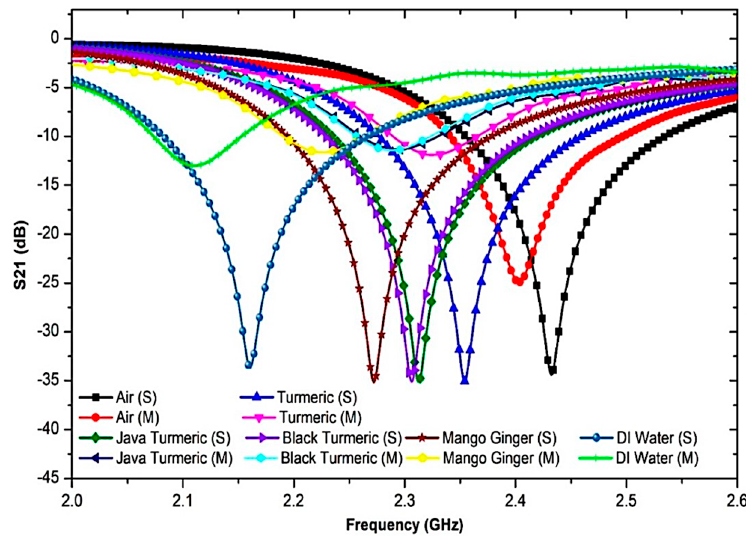
Figure 17. Comparison simulation and measurement of triple-rings CSRR sensor with several semi-solid samples. Table 6. Comparison between the simulation and measurement of resonant frequency shift across the several